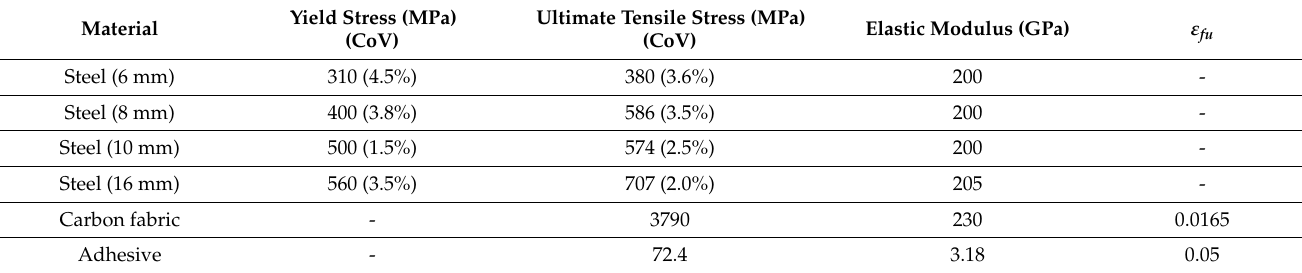
Table 2. Tensile properties of steel reinforcement and CFRP